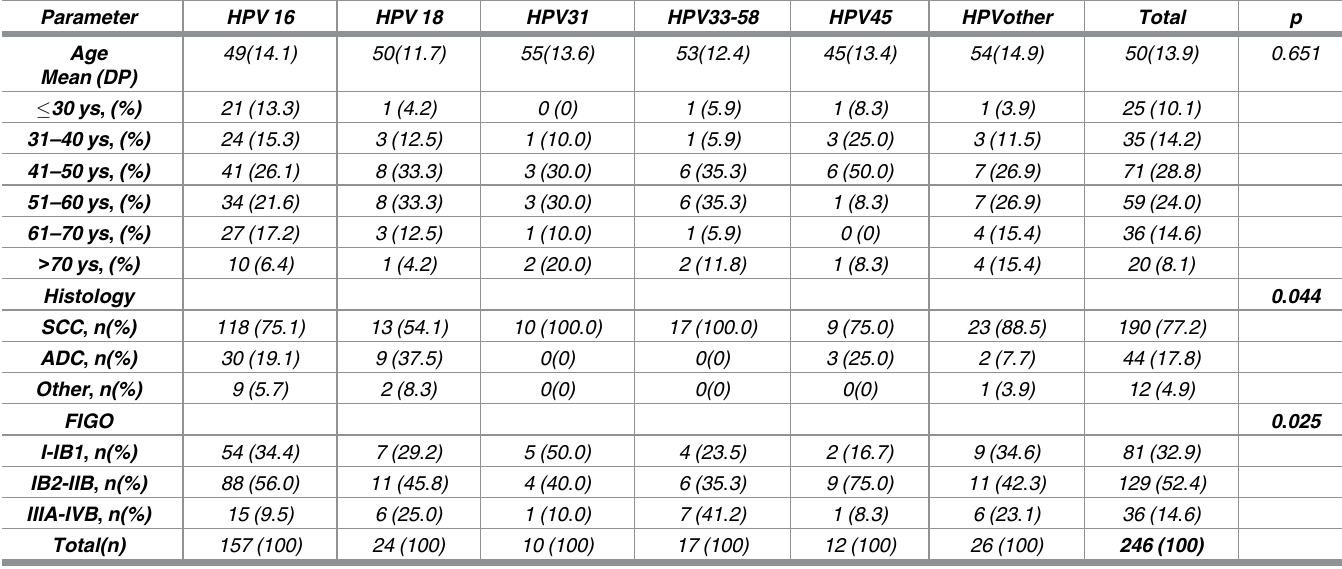
Table 2. Distribution of the most frequent HPV genotypes according to clinical and pathological